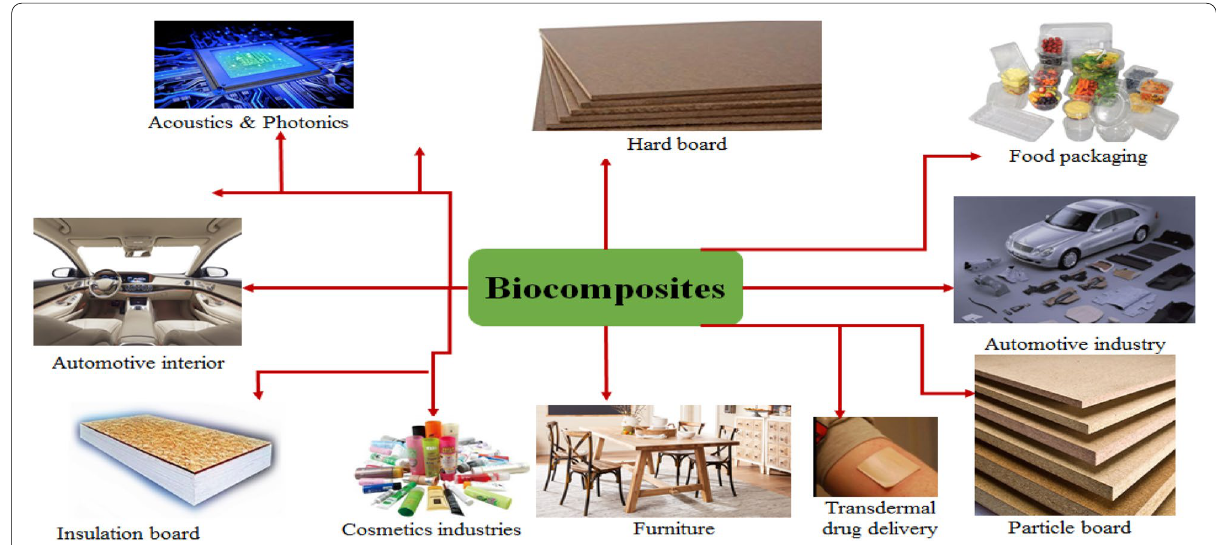
Fig. 14 Possible applications of biocomposites from pulp and paper mill